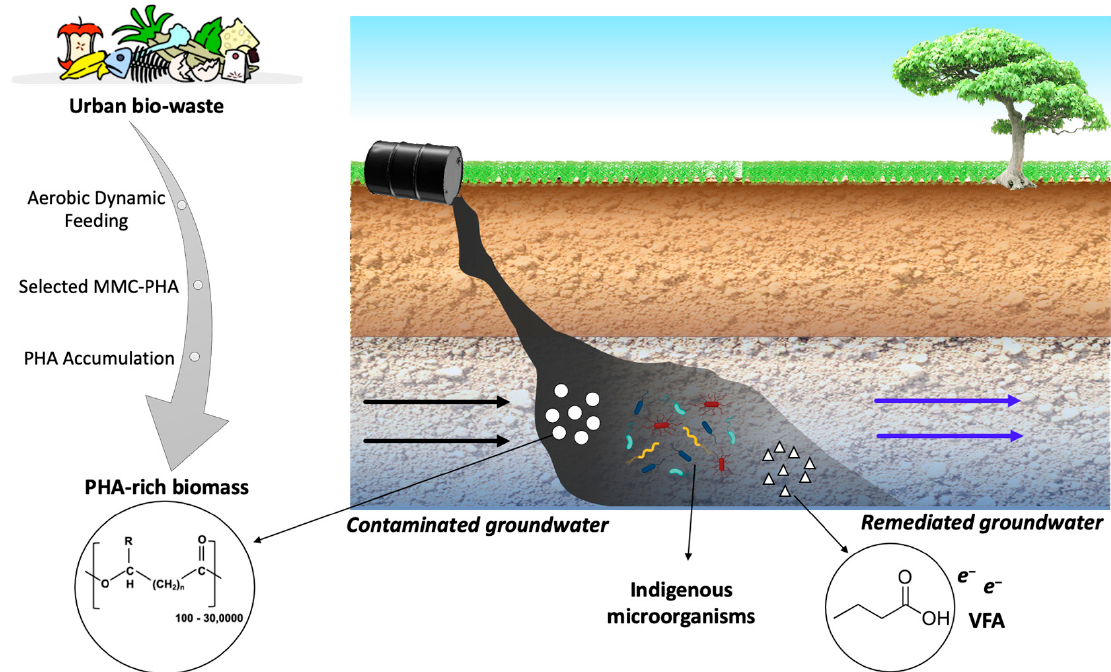
Figure 3. Schematic application of polyhydroxyalkanoates (PHA) from selected mixed microbial culture (MMC) for biological reductive dechlorination (RD). Created with Biorender.com (accessed on 1 April